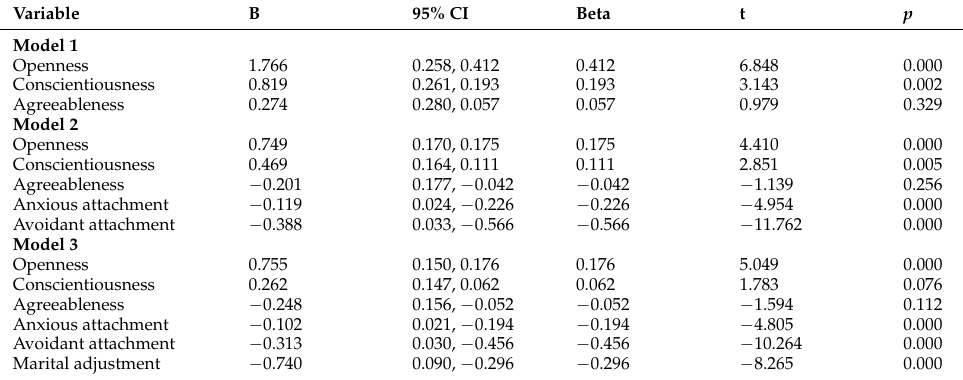
Table 2. The beta coefficients for the multiple linear regression analysis for the investigated variables: relationship satisfaction, openness, conscientiousness, agreeableness, anxious attachment, avoidant attachment, and marital adjustment.